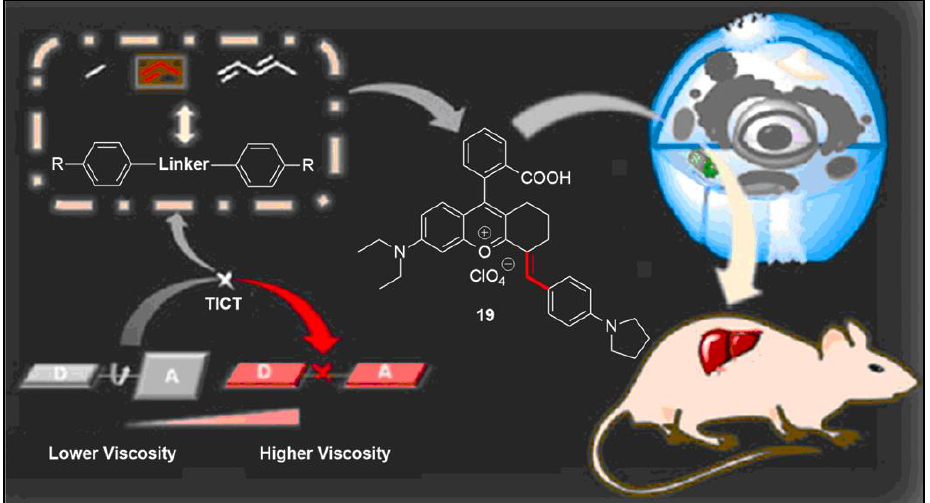
Figure 20. Molecular structure of probe 19 and the viscosity sensing mechanism. Adapted with permission from [86]. Copyright (2022) Elsevier.